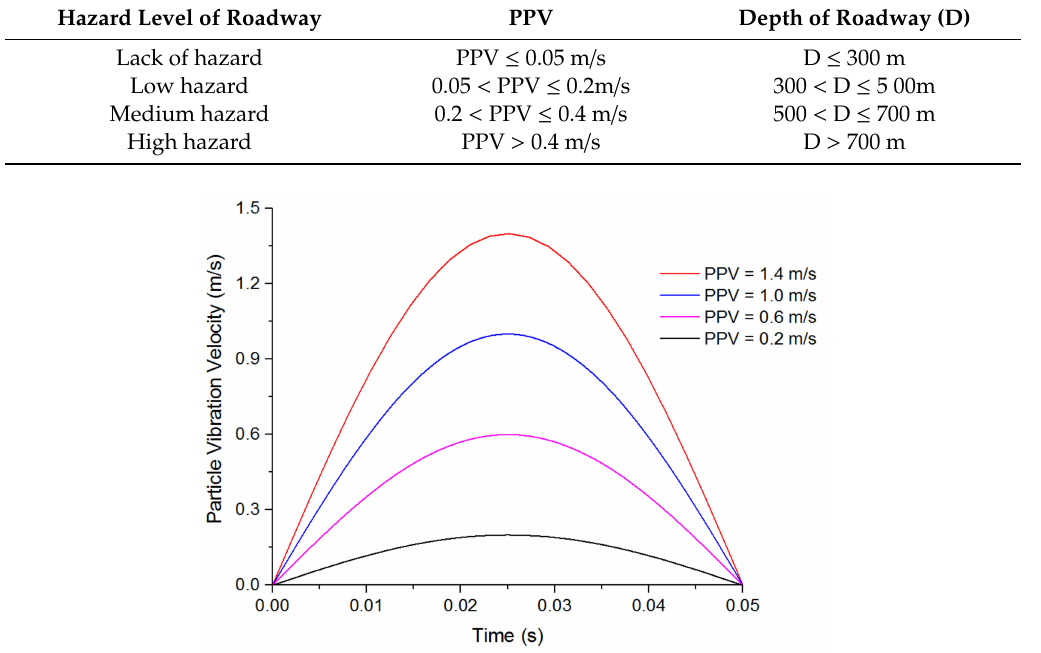
Figure 5. Waveforms of four di ff erent dynamic